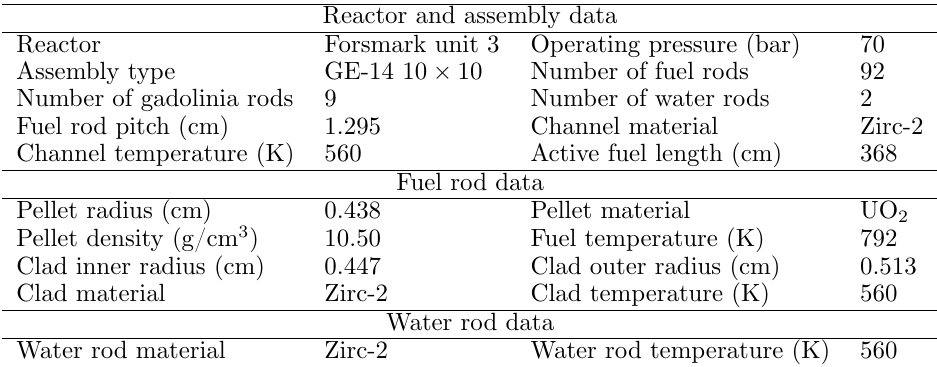
Fig. 1. Assembly GN592, GE-14 type, with various rod types. The rod J8 containing the 8 samples is indicated in red for the transverse view. On the right is indicated the axial sample positions. Segments in green corresponds to natural uranium [6]. Table 1. Parameters for the assembly GN592, as presented in reference